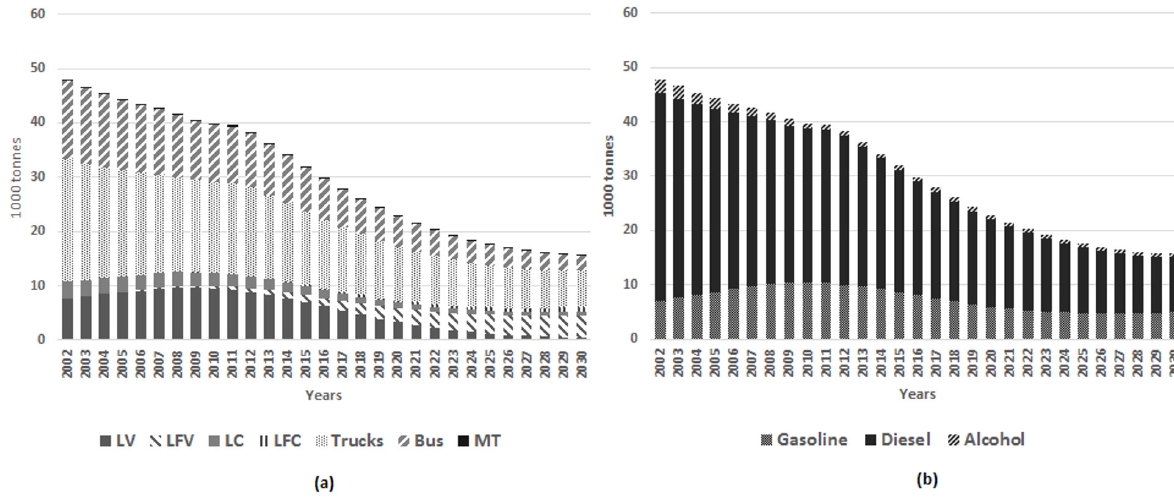
in the MRPA (associated with the pessimistic estimation of the fleet) for the period between Figure 4 - Emission scenarios of NO x 2002 and 2030. ( a ) Scenarios by vehicles categories. ( b ) Scenarios by type of fuel.